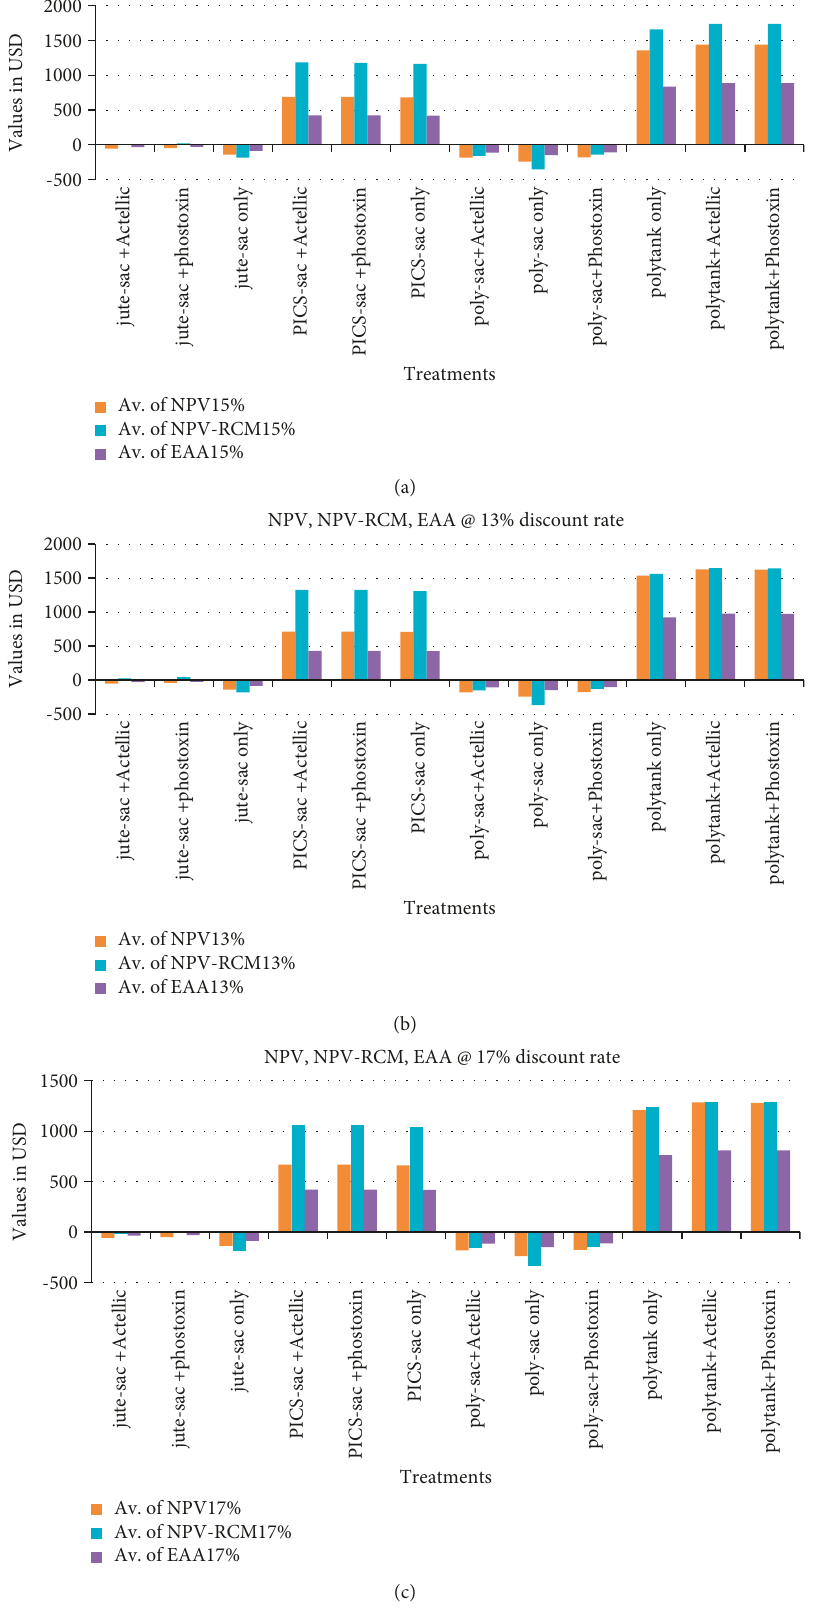
Figure 8: NPV, NPV-RCM, and EAA at a discount rate of 15%, 13%, and